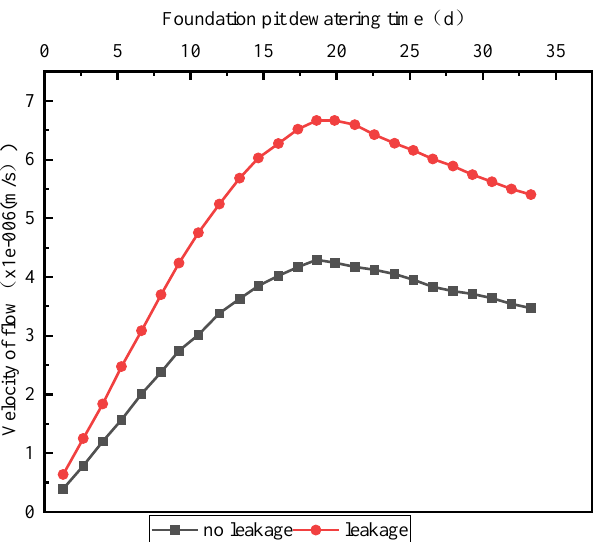
Figure 12. The curve of water flow velocity with precipitation time in the envelope with and without leakage.